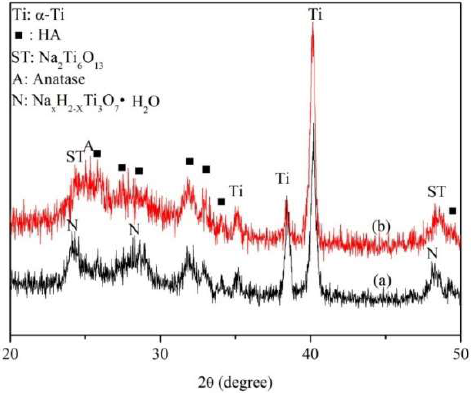
Figure 3. X-ray di ff ractometry (XRD) patterns of HA-coated c.p. Ti samples after hydrothermal Figure 3. X-ray diffractometry (XRD) patterns of HA-coated c.p. Ti samples after hydrothermal Figure 3. X-ray diffractometry (XRD) patterns of HA-coated c.p. Ti samples after hydrothermal Figure 3. X-ray diffractometry (XRD) patterns of HA-coated c.p. Ti samples after hydrothermal treatment at 150 ◦ C for 48 h: non-heat-treated surface ( a ) and heat-treated surface at 500 ◦ C for 2 h ( b treatment at 150 °C for 48 h: non-heat-treated surface ( a ) and heat-treated surface at 500 °C for 2 h ( b ). treatment at 150 °C for 48 h: non-heat-treated surface ( a ) and heat-treated surface at 500 °C for 2 h ( b ). treatment at 150 °C for 48 h: non-heat-treated surface ( a ) and heat-treated surface at 500 °C for 2 h ( b ).